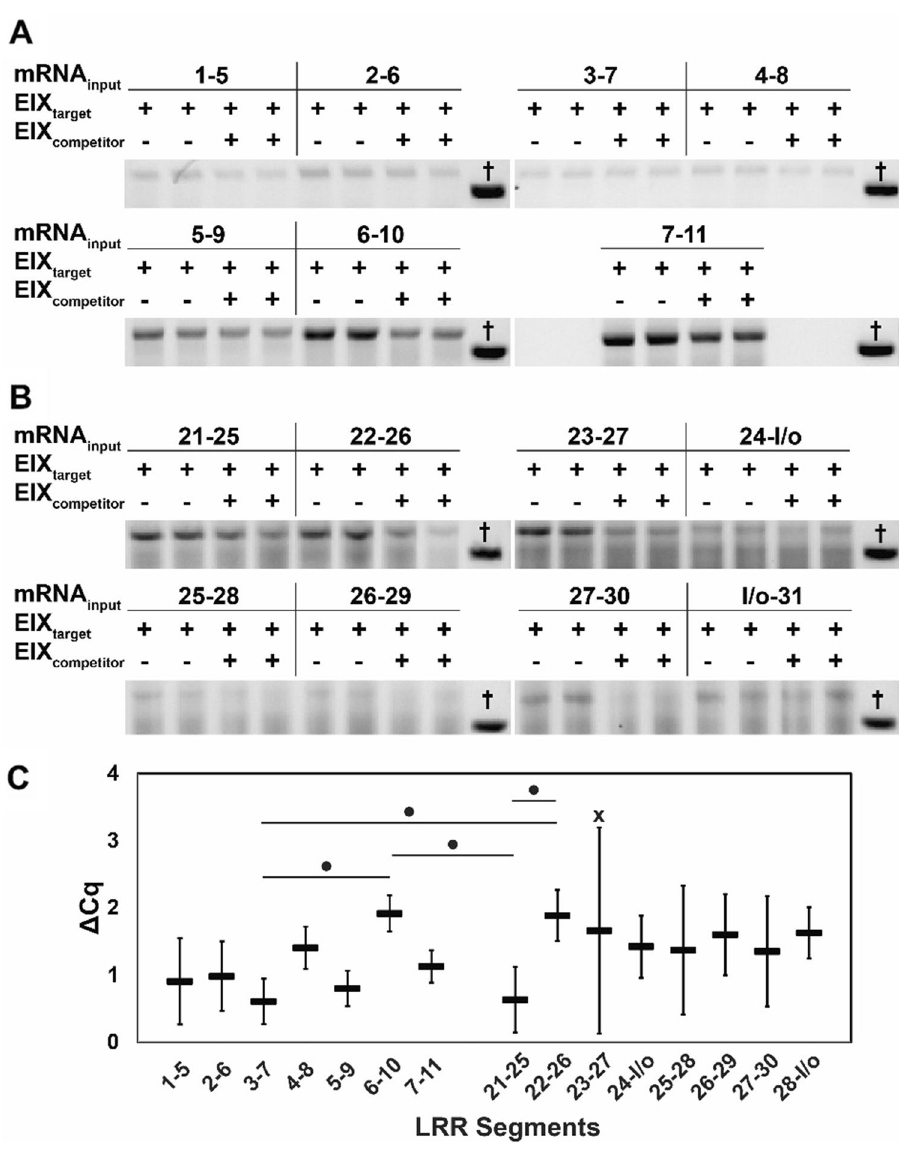
Figure 3. 5-LRR sub-segment mapping. Gel electrophoresis results for RD technical duplicates of ( A ) LRRs 1–5 to 7–11 or ( B ) LRRs 21–25 to loopout (l/o)-31 panning against immobilized EIX target in the absence or presence of excess competitor EIX. An unrelated RT-PCR sample (†) serves as a loading control so that signal intensities across gels can be compared. ( C ) ΔCq means calculated from normalized qRT-PCR replicates measured in 5-LRR sub-segment RD experiments. Error bars represent replicate standard deviations. • p ≤ 0.1 for Tukey’s method pairwise comparison of ΔCq following single-factor ANOVA. A high-variance data point (x) was identified as an outlier by Tukey’s heuristic and excluded from statistical